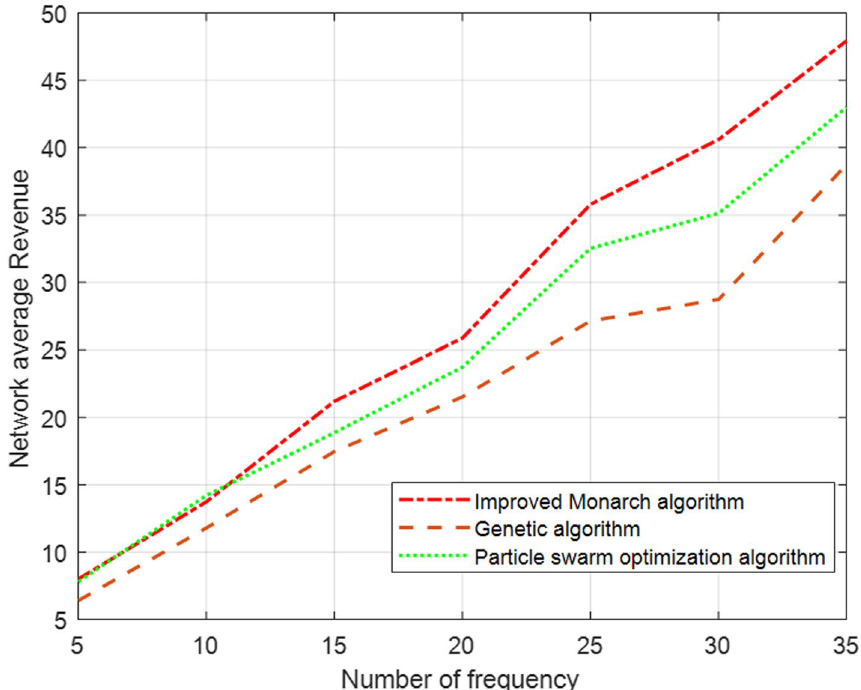
Fig. 9 Average income transformation of the network, when T